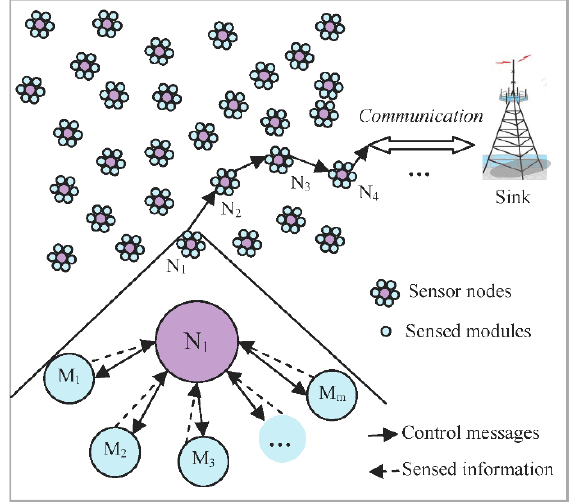
Figure 3. Schematic diagram of the network (Figure 3 is only a sketch map. The number of the sensed modules of the nodes in Figure 3 does not represent the actual number of the sensed modules).